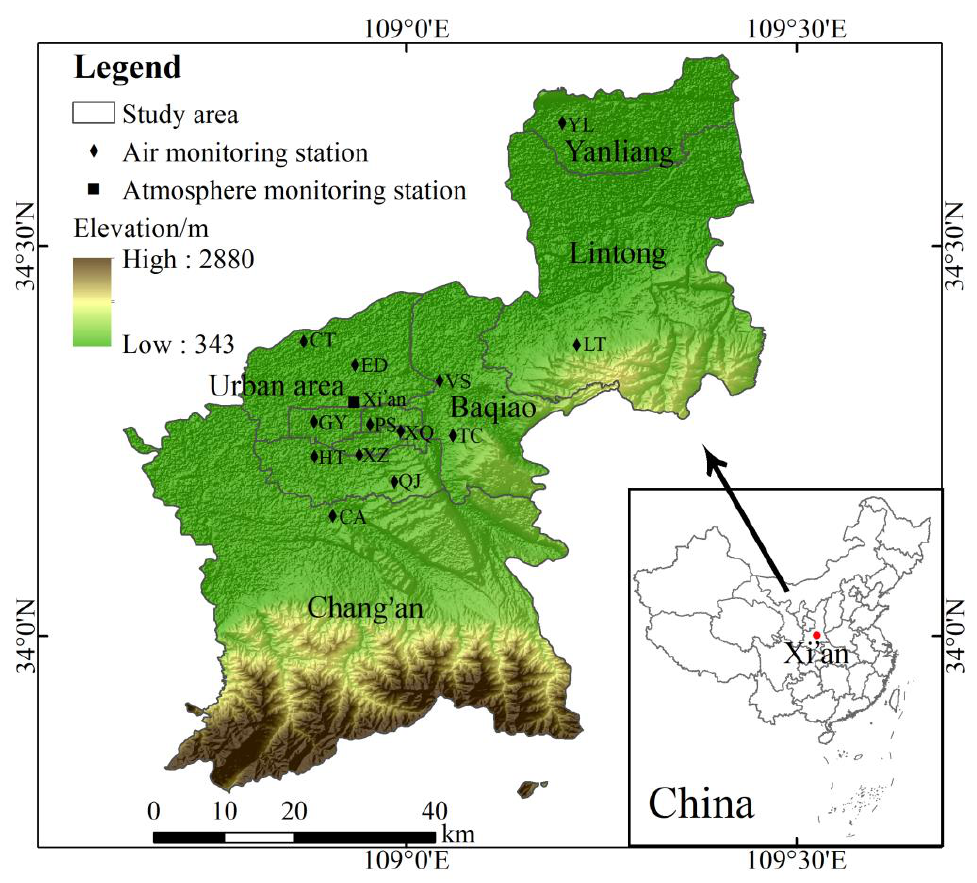
Figure 1. Distribution of air monitoring stations and atmosphere monitoring station. According to the emissions standards of air pollutants from the Ambient Air Quality Standard (GB 3095-2012) [23]. Grade 1 concentration limits (24 h average) of PM10 and PM2.5 are 50 µ g/m 3 and 35 µ g/m 3 , which are the maximum concentrations healthy for humans. Grade 3 concentration limits of PM10 and PM2.5 are 150 µ g/m 3 and 75 µ g/m 3 , which are unhealthy for